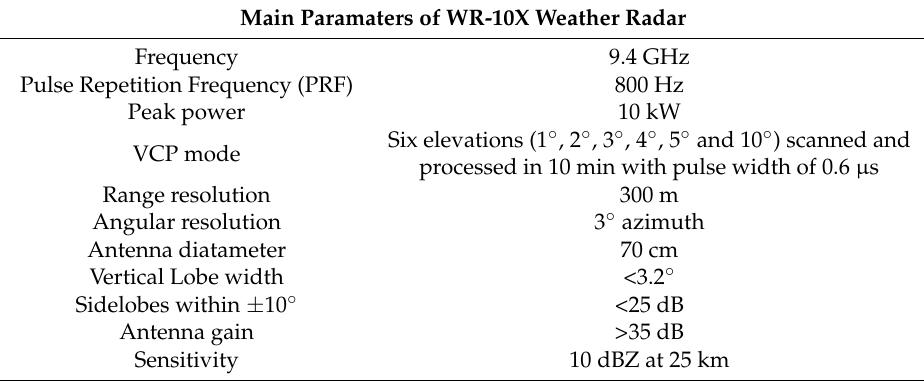
Table 2. Technical features of WR-10X weather radar operating in Naples urban